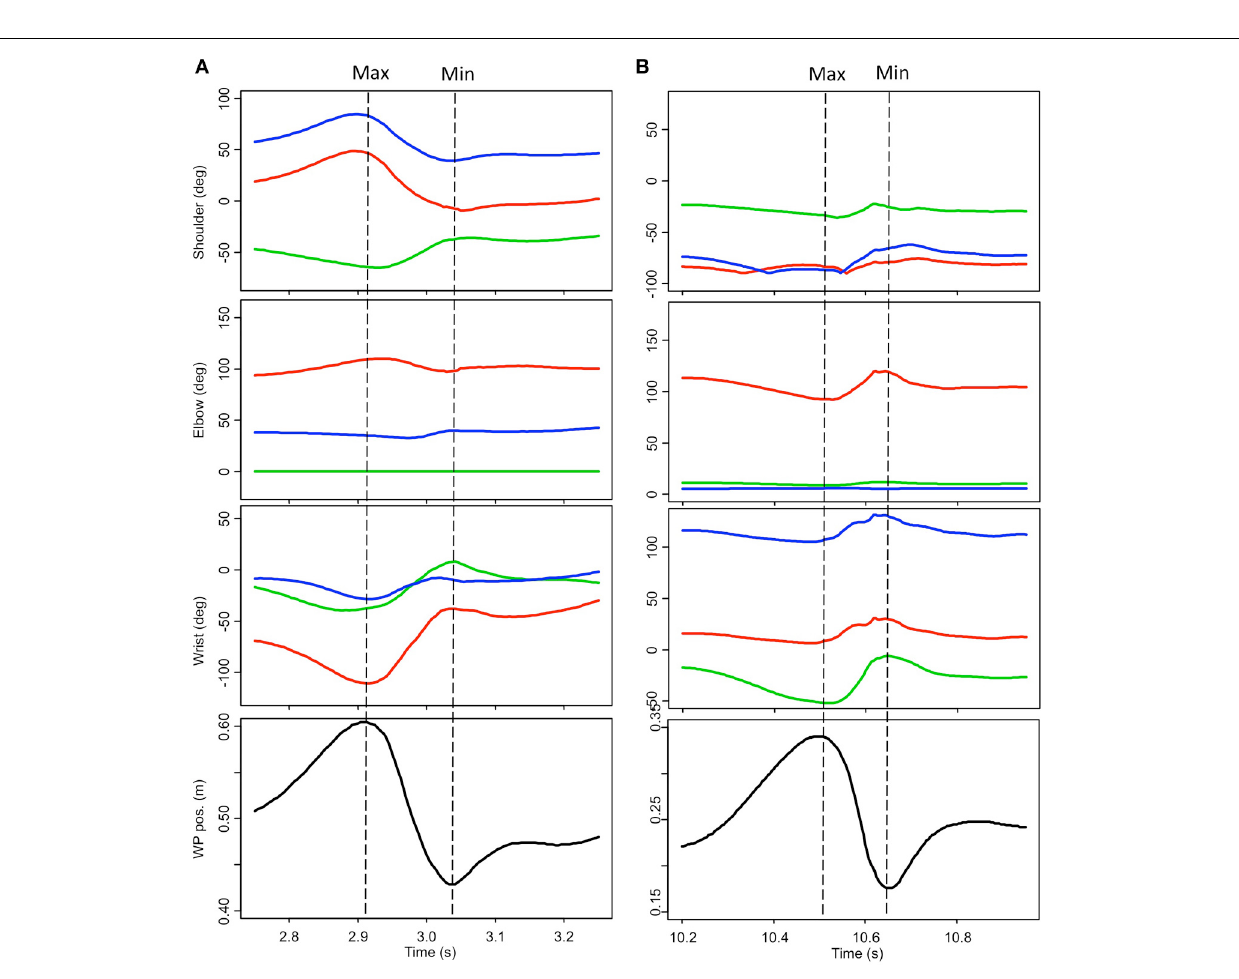
of the working point along the vertical axis is depicted in the bottom-most panel. No data presented here has been filtered. Max and min indicated the beginning and the end of the striking movements